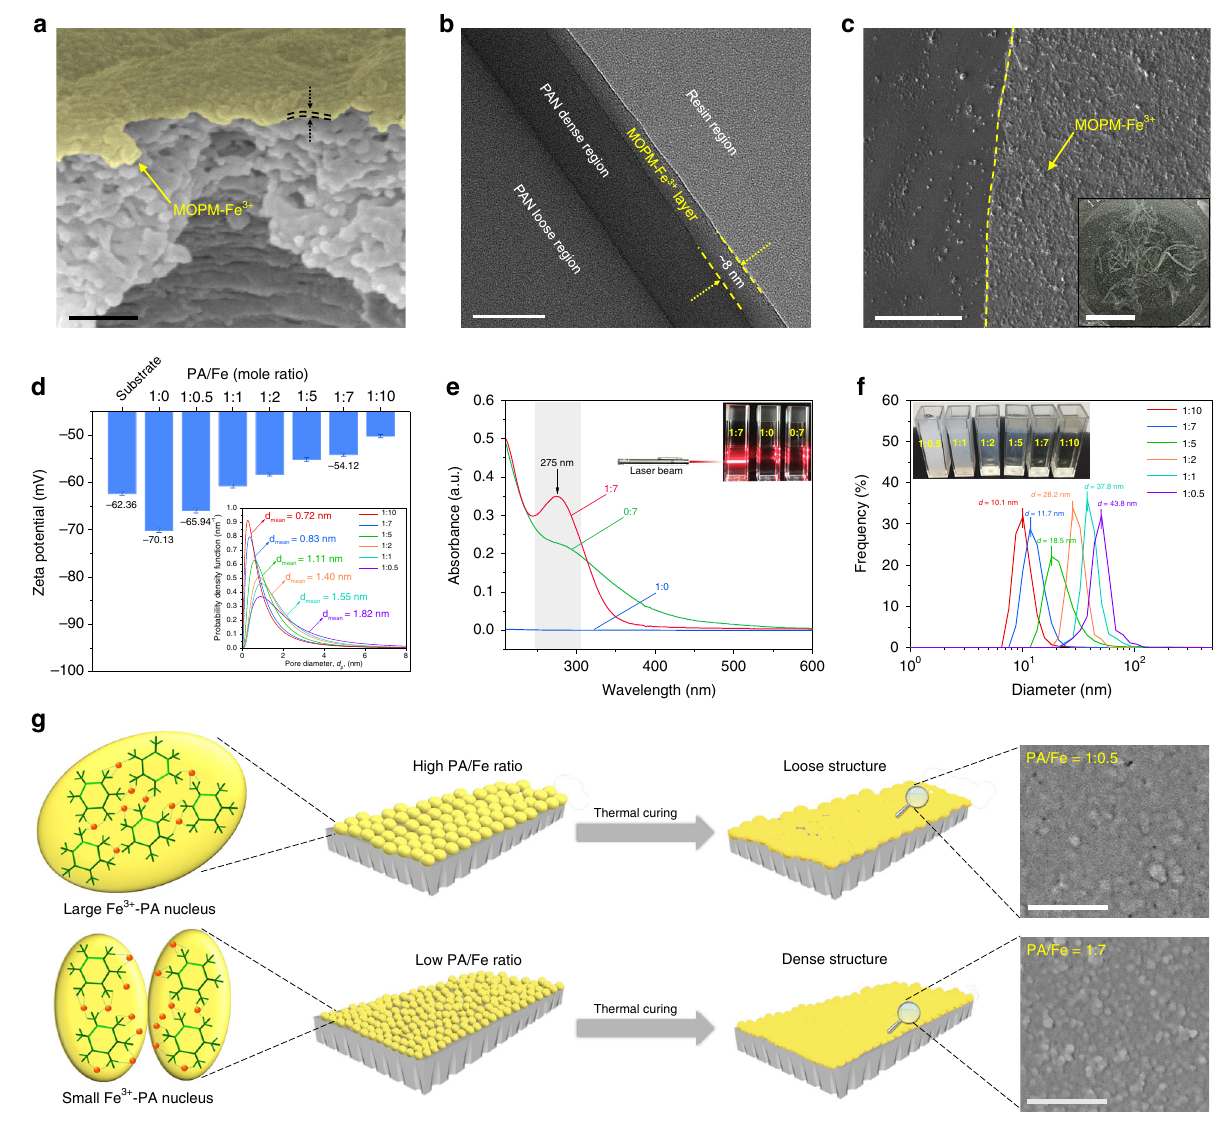
Fig. 2 Optimizing assembly behavior for ultrathin MOPMs. a SEM images of MOPM-Fe 3 + on PAN substrate. False color of yellow was utilized to singularize the MOPM-Fe 3 + . Scale bar: 100 nm. b TEM image of MOPM-Fe 3 + on PAN substrate. Scale bar: 20 nm. c Transferred MOPM-Fe 3 + on silicon wafer. Scale bar: 1 μ m. Inset in c : Digital photograph of substrate-free MOPM-Fe 3 + in DMF. For a – c , the PA concentration was 0.015 mg/mL. d Surface zeta potential of membranes. Inset in d : Effective pore size distribution of MOPM-Fe 3 + with varied PA/Fe ratio using PEG as molecular probe. e Ultraviolet- visible spectra of aqueous solutions with different PA/Fe ratio. Inset in e : Photograph of aqueous solutions with different PA/Fe ratio under laser bean irradiation. f Size distribution of Fe 3 + -PA complexes in assembly solution with varied PA/Fe ratio detected by dynamic light scattering. Inset in f : Digital photo images of MOPM-Fe 3 + complexes with varied PA/Fe ratio. g Schematic illustration of growth and formation for MOPM-Fe 3 + with high and low PA/ Fe ratio. Inset in g : SEM images of MOPM-Fe 3 + with PA/Fe ratio of 1:0.5 (top) and 1:7 (bottom). Scale bar: 200 nm. Error bars represent standard deviations for 3